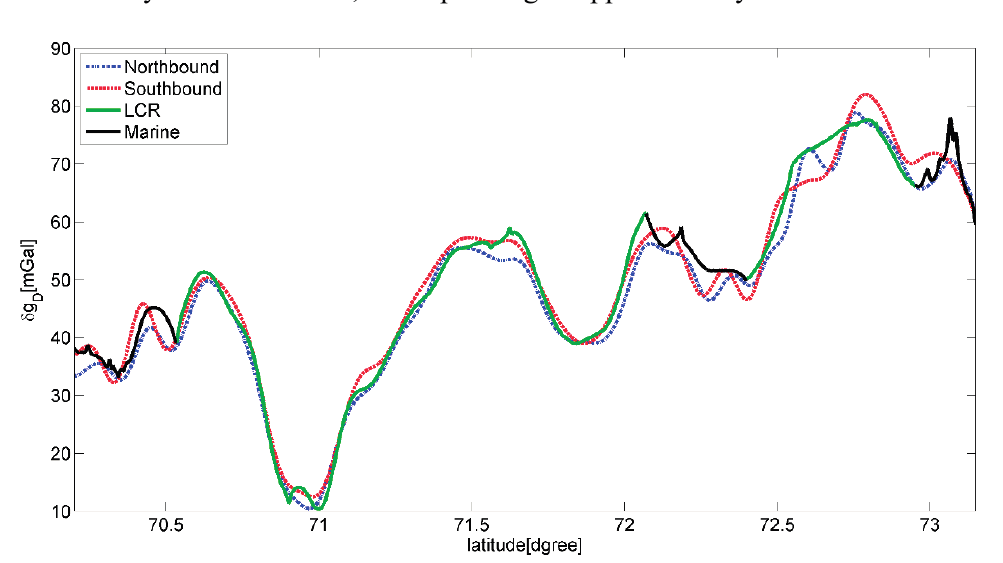
Figure 7. Comparisons of gravity disturbance between the Northbound (blue) and Southbound (red) of the flight A and the former LCR data (green) and marine data (black). Table 1. The statistic of the differences between the repeated line and LCR data (Units: mGal). Items Min Max Mean RMS Northbound-Southbound − 7.5 5.5 − 1.7 1.5 Northbound-LCR − 7.3 2.6 − 1.7 2.0 Southbound-LCR − 7.8 4.8 − 0.0 2.6 Mean(SGA-WZ)-LCR − 7.6 3.1 − 0.9